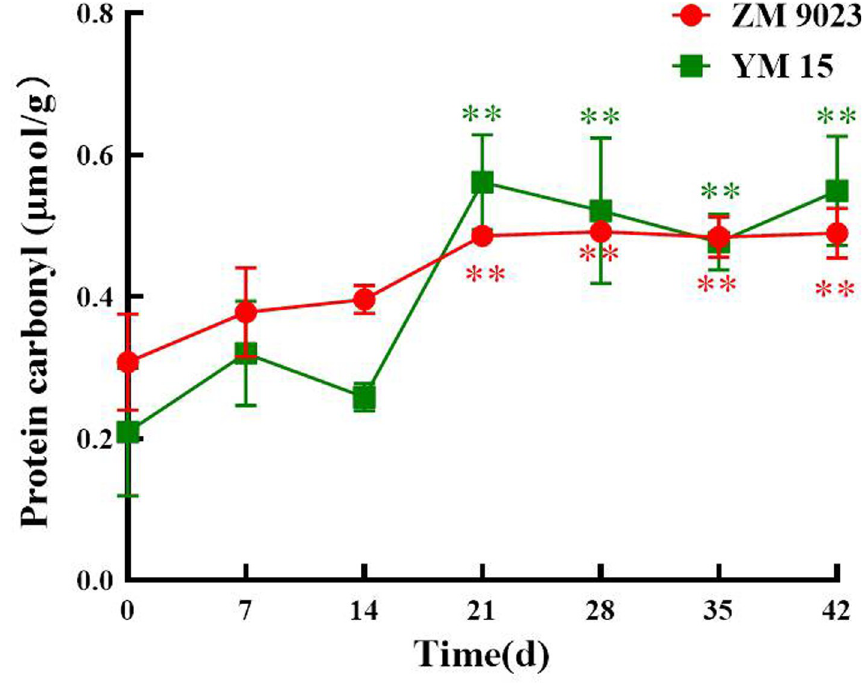
Fig 2. Changes in the carbonyl protein contents of the wheat cultivars ZM 9023 and YM 15 during artificial aging. At least three independent experiments were performed; data are shown as mean ± SD. � p < 0.05; �� p < 0.005. https://doi.org/10.1371/journal.pone.0263553.g002 from 2.70 μ moL/g to 5.53 μ moL/g for the former and from 6.73 μ moL/g to 10.96 μ moL/g for the latter during artificial aging.